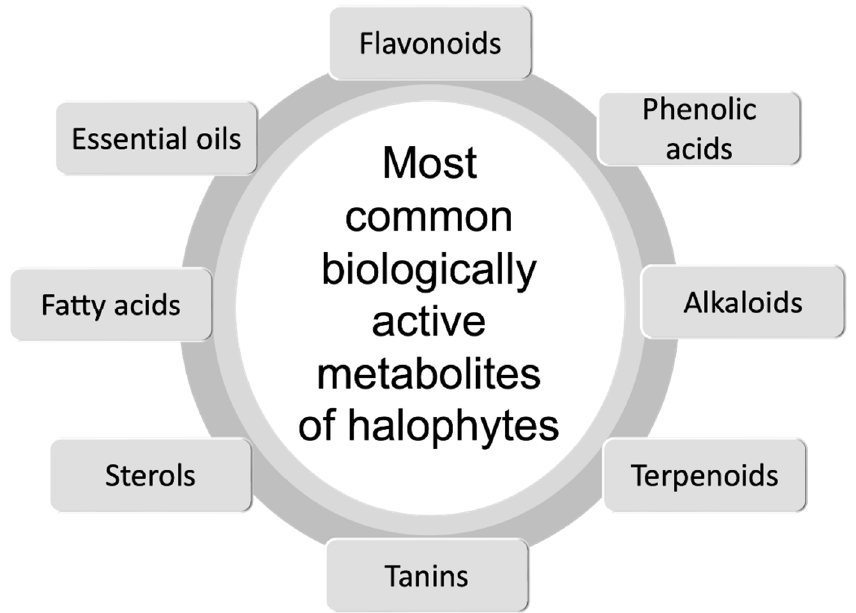
Figure 4. Most common bioactive compounds produced by halophyte plants.